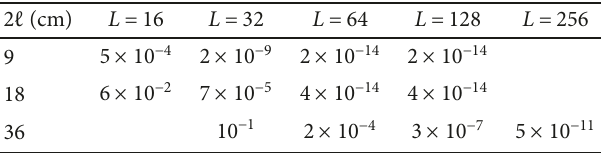
Table 5: The NRMSE of the fi eld (39) in the empty casing as a function of the number of equivalent sources L for di ff erent sizes O : (1) 1/2 2 ℓ of the mesh.